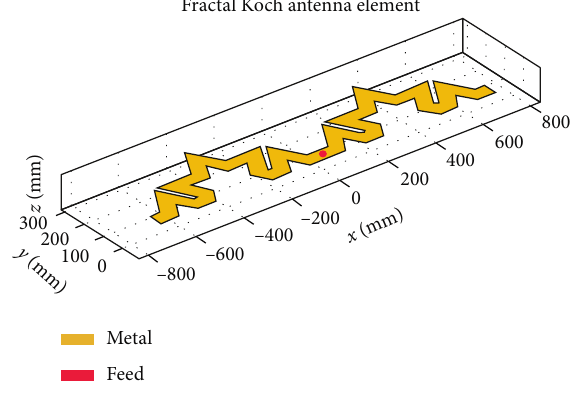
Figure 11: Fractal Koch antenna (iteration 2).